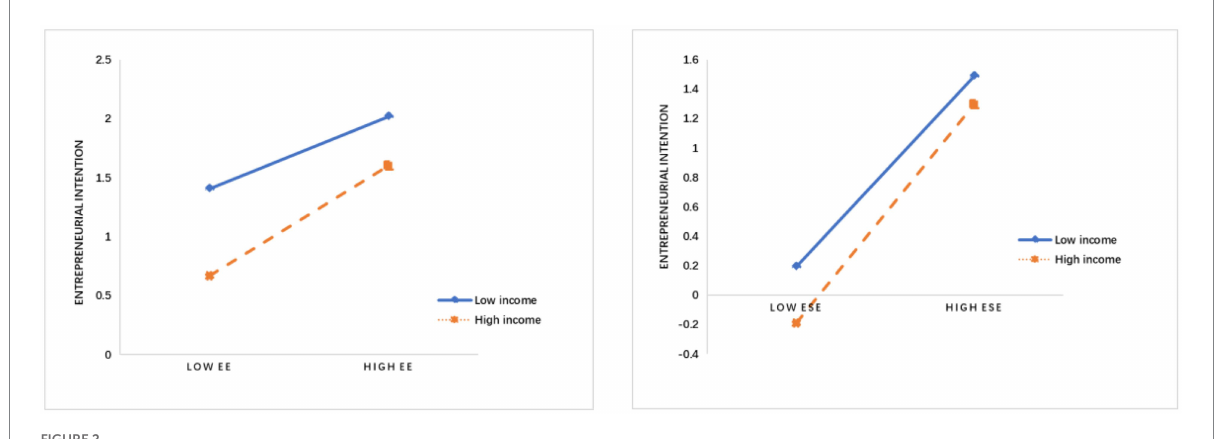
FIGURE 2 The moderating effect of family income in EE → EI and ESE →